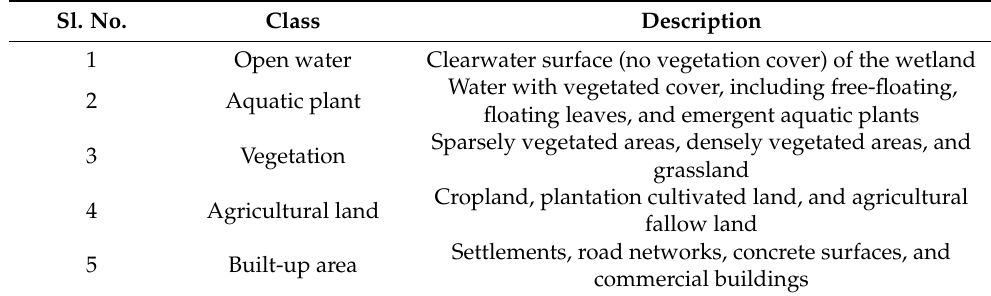
Table 1. Description of LULC classes. Sl. No.